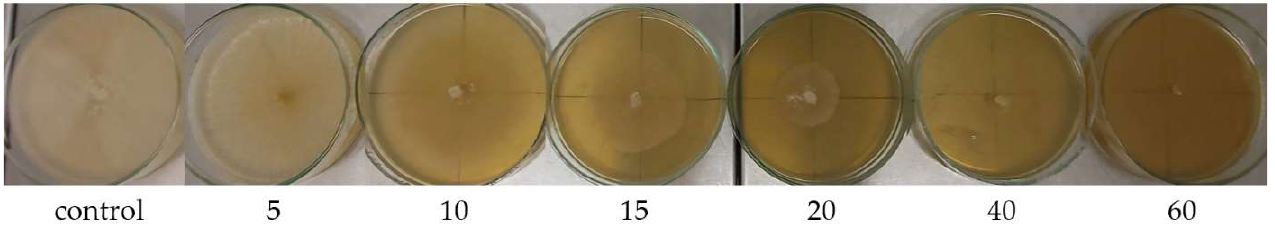
Figure 4. Growth of T. viride on a malt-agar medium containing various amounts (mL/100 mL) of mint extracts M. × piperita ‘Almira’.